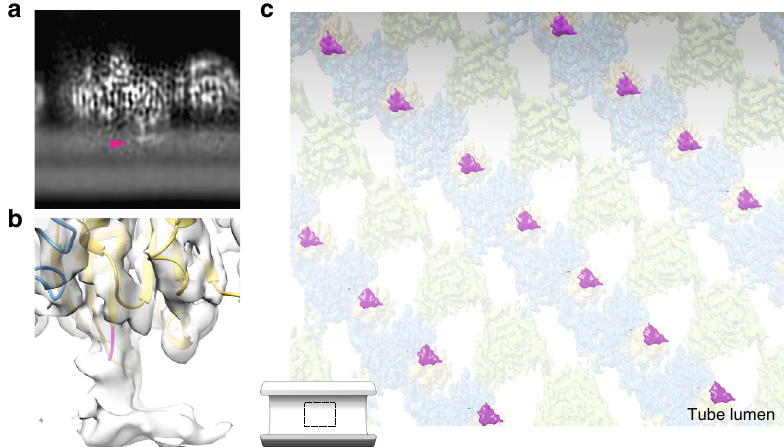
Fig. 3 Sar1 amphipathic helix membrane insertion. a XZ slice through the cryo-EM density map, showing the lipid bilayer, and a strong density protruding from the protein core and inserting into the outer lea fl et (magenta arrowhead). b Surface representation of the membrane inserted region shows continuity with the N-terminus of Sar1 X-ray structure, which lacks the Sar1 amphipathic helix. The N-terminal residue of the X-ray structure is depicted in magenta. c The back-plotted density is shown from the inside of a tube, highlighting the Sar1 amphipathic helix in magenta